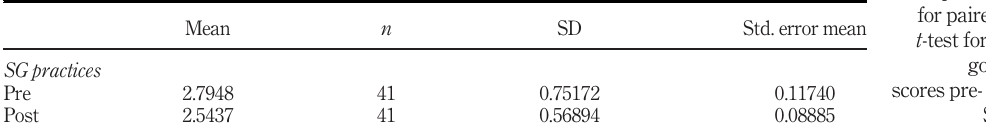
for paired sample t -test for Shar ī ʿ